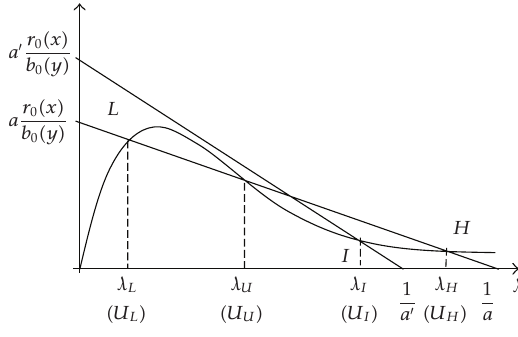
Figure 6: Three stable